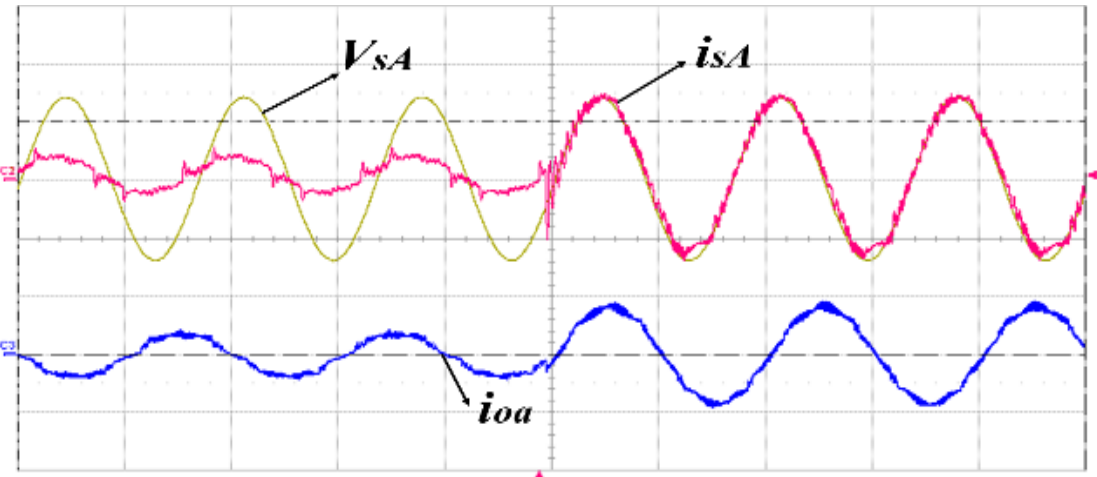
Figure 19. Experimental results of the proposed strategy with the IFRS, where output-current reference amplitude is changed from 2.15 A to 4.3 A and output-current frequency is set to 50 Hz, x-axis 10 ms/div. Waveforms of the source voltage 𝑉 𝑠𝐴 (100 V/div), source current 𝑖 𝑠𝐴 (2 A/div) and output current 𝑖 𝑜𝑎 (5 A/div).